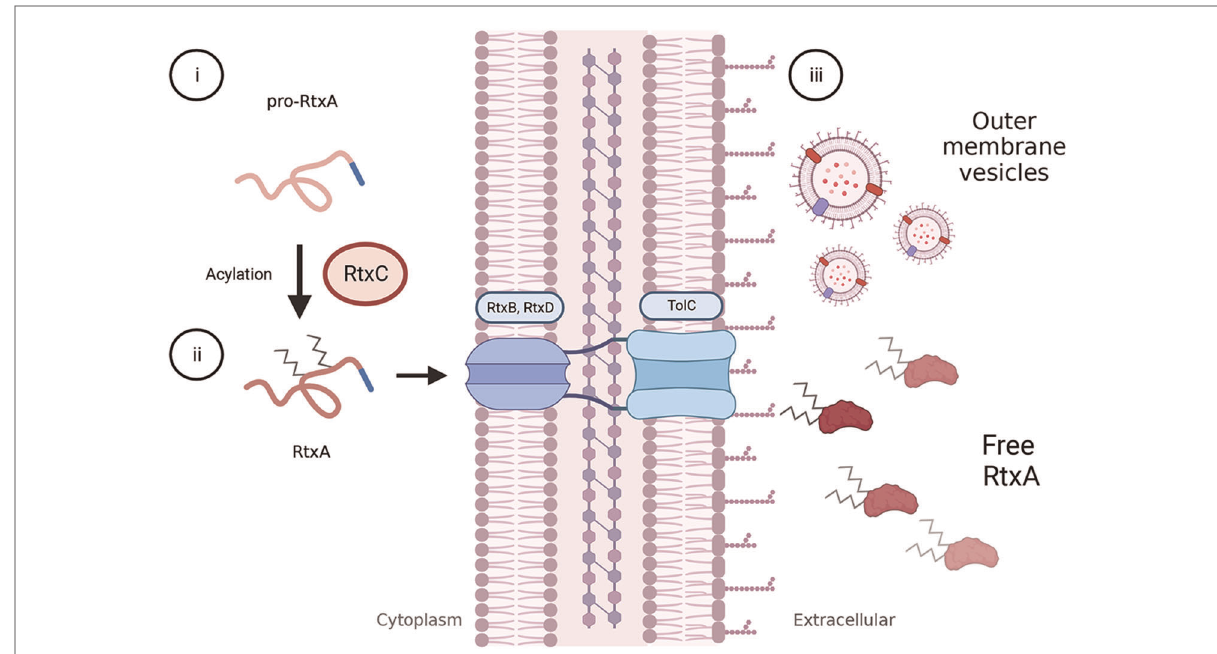
FIGURE 2 Activation and secretion of RtxA. The rtxA gene encodes a pro-toxin in K. kingae. Following translation, pro-RtxA remains unfolded and associates with RtxC in the cytosol, possibly near the cell membrane. (i) RtxC catalyzes the addition of an acyl-moiety onto each of two, conserved lysine residues. (ii) As with other RTX toxins, RtxA is thought to remain unfolded until it is exported from the bacterial cell via a type I secretion system comprised of RtxD and RtxB in the inner membrane and TolC in the outer membrane. Export is facilitated by a C-terminal secretion signal, and folding is likely mediated through the interaction of extracellular calcium with the RtxA calcium-binding domain. (iii) Outside of the cell, RtxA is found in a free state in spent media as well as in association with outer membrane vesicles (OMVs). It is unclear if the OMV-associated toxin is within the OMV or associated with the membrane. Both free RtxA and OMV-associated RtxA can cause host cell